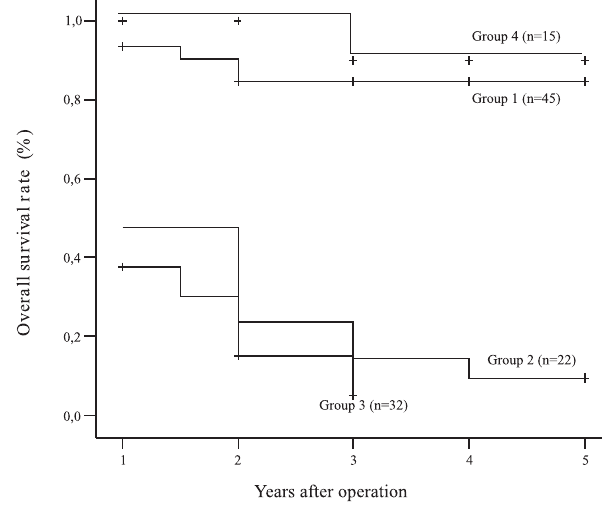
Figure 3 - Comparison of survival for groups 1-4